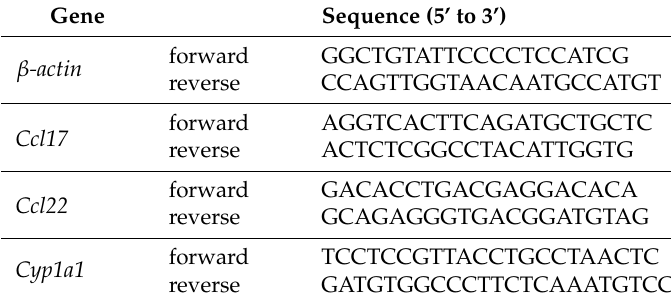
Table 1. The sequences of